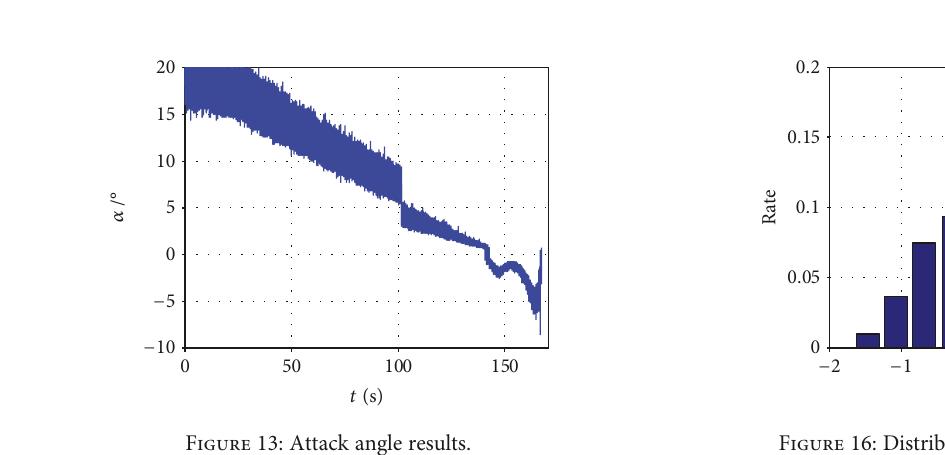
Figure 13: Attack angle results.